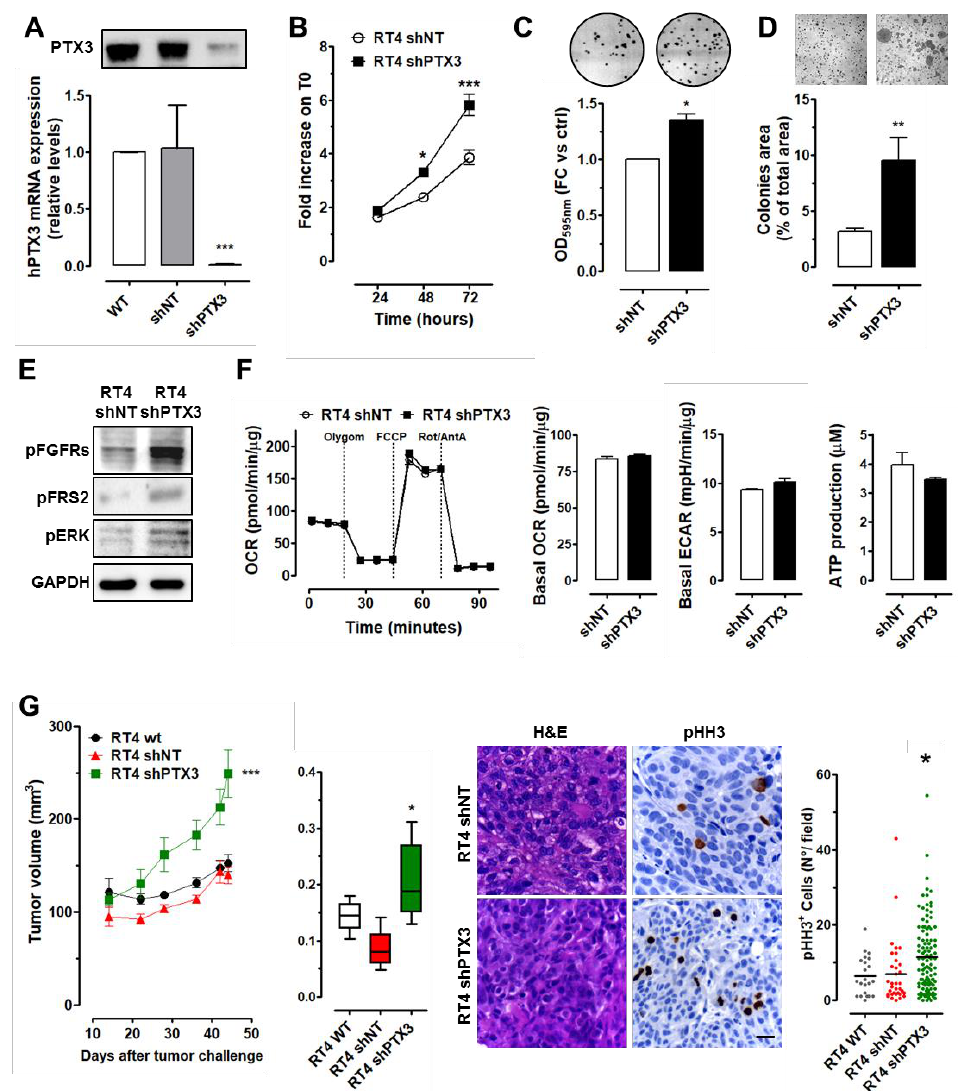
Figure 2. PTX3 silencing in low-grade RT4 BC cells. ( A ) PTX3 expression (mRNA and protein levels) in silenced (shPTX3), control (shNT), and wild type (WT) RT4 cells. Characterization of RT4 cells by cell proliferation ( B ), colony formation ( C ), and soft agar ( D ) assays. ( E ) Western blot analysis of pan-FGFR, FRS2, and ERK phosphorylation. ( F ) Seahorse Mito Stress Test and ATP production analysis performed on RT4-shPTX3 and RT4-shNT cells. ( G ) Tumor growth and weight of RT4 cell xenografts. Hematoxylin and eosin (H&E) and pHH3 immunostaining quantification performed on tumor samples. Magnification: 40 × ; scale bars: 20 µ M. Data are expressed in scatter plot graphs. * p < 0.05, ** p < 0.01, *** p < 0.001.